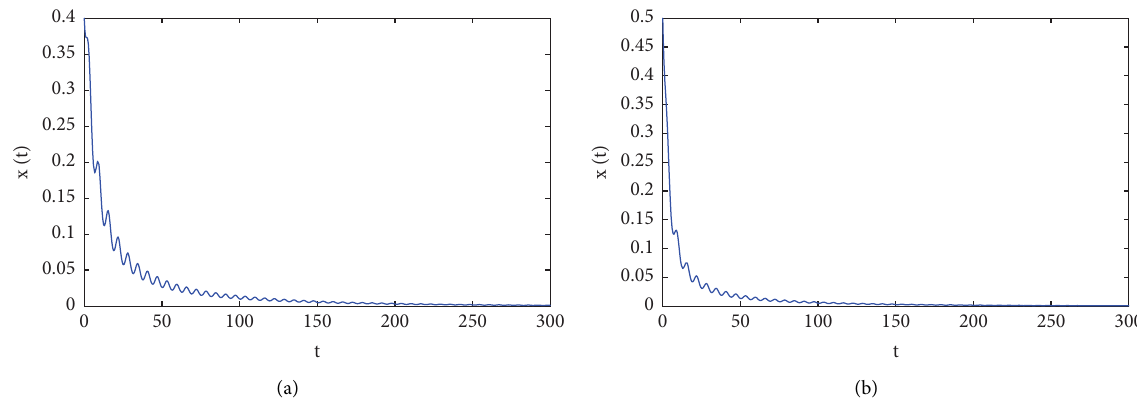
Figure 1: Te lines represent the solution of model (8) for r ( t ) � − 0 . 01 + 0 . 2sin t,K � 1, initial data x C � 0 , a ( t ) � 0 . 5 , σ ( t ) � c ( u ) � 0; (b). C � 0 ,a ( t ) � 1 , σ ( t ) � c ( u ) � 0.